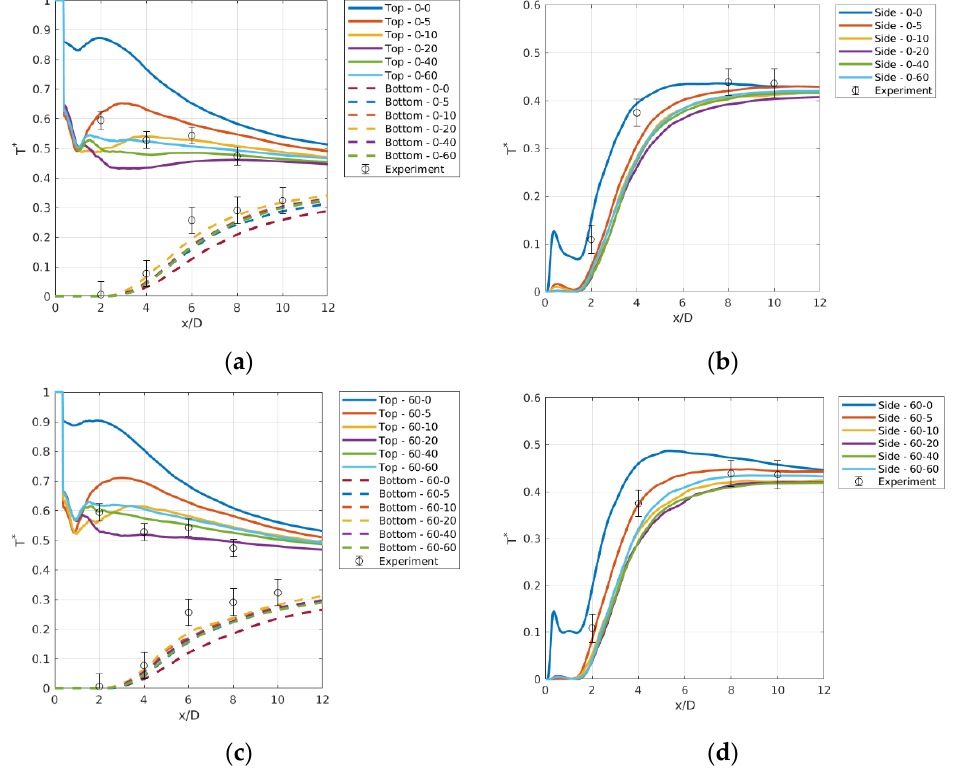
Figure 7. Profiles of 𝑇 ∗ at top, bottom, and side pipe for cases with uniformly distributed BCs and experimental data [23,24] at the main inlet, ( a , b ), and cases with fully developed BCs at the main inlet, ( c , d ).